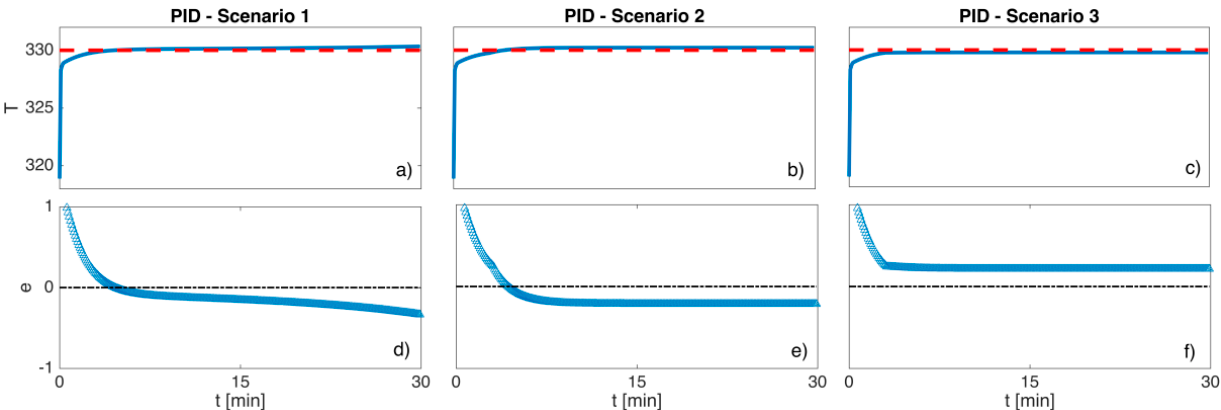
Figure 7. The plant response under PID control in all three scenarios. The figure is structured in two rows of three pictures, in the first row ( a – c ) show the plant output (blue line) and the set point (red dashed line); in the second row ( d – f ) show the resultant control error (blue markers) is plotted against the zero error line (black dashed line).